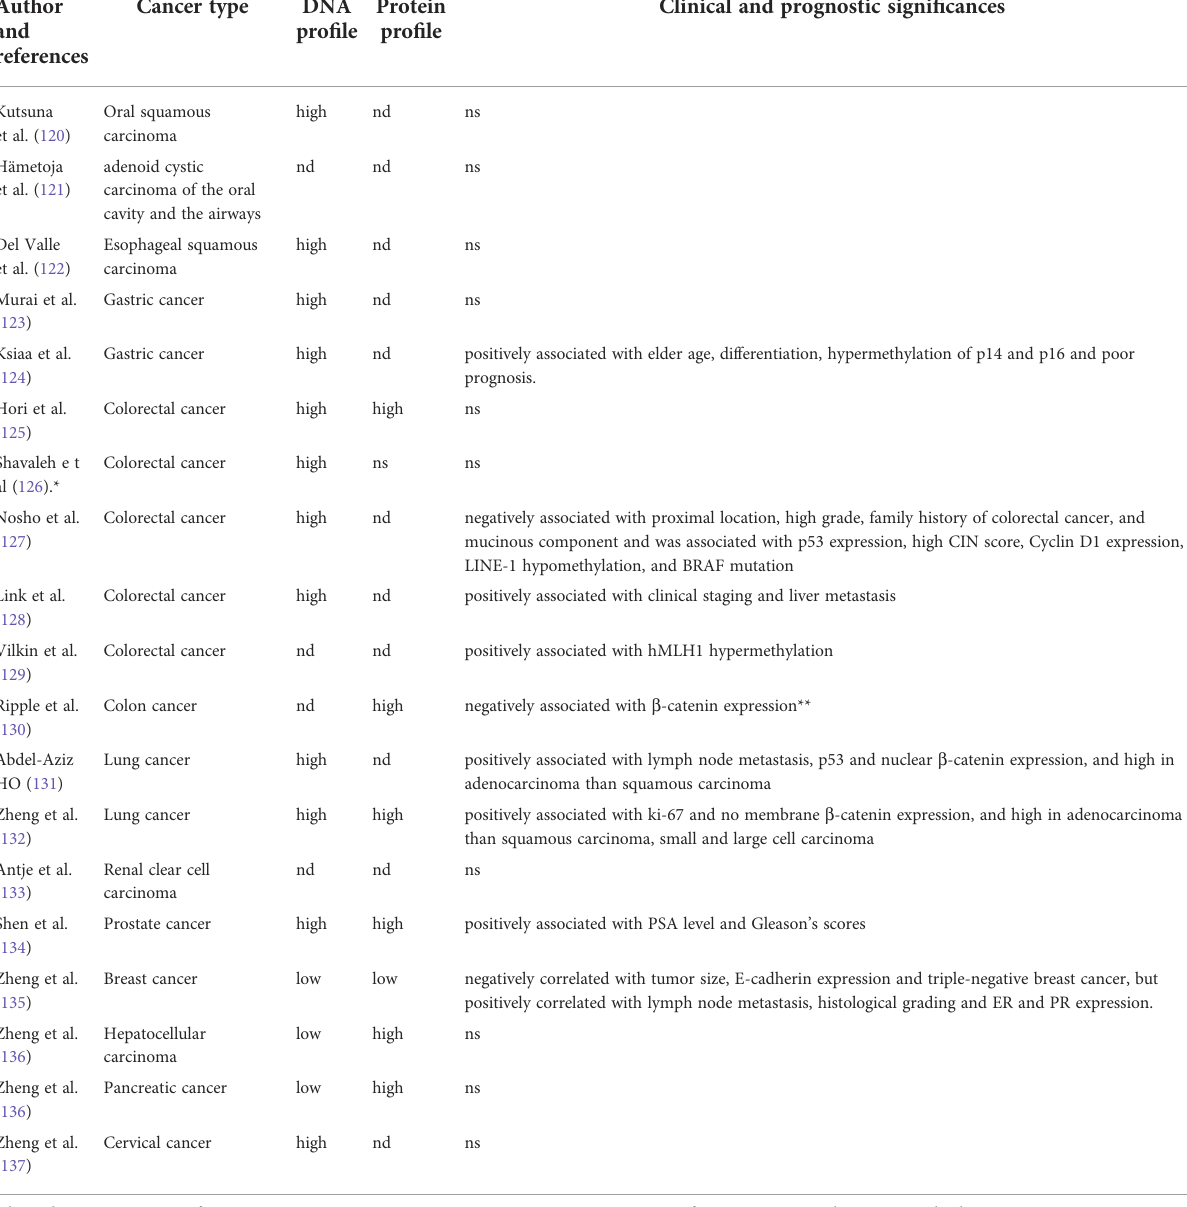
TABLE 2 The correlation of JCPyV T antigen with carcinogenesis and subsequent